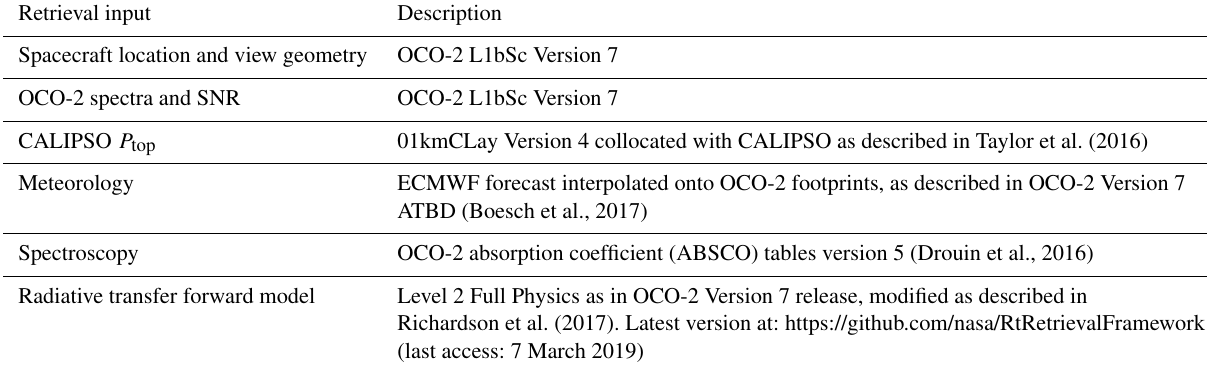
Table 2. Product names, version numbers and citations for key inputs and the forward model used in OCO2CLD-LIDAR-AUX. Retrieval